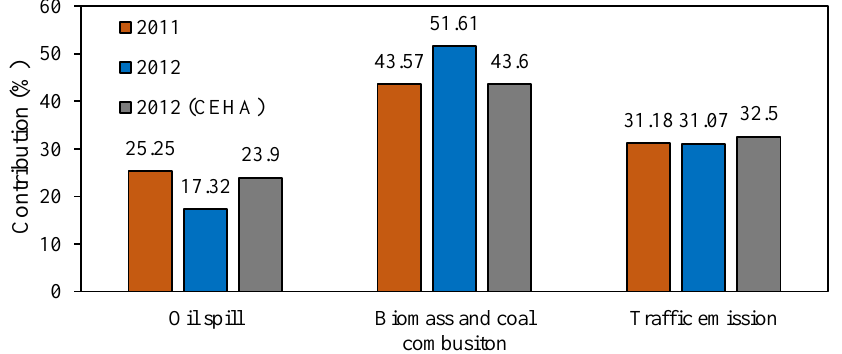
Figure 6. Source contributions based on the advanced PMF model.